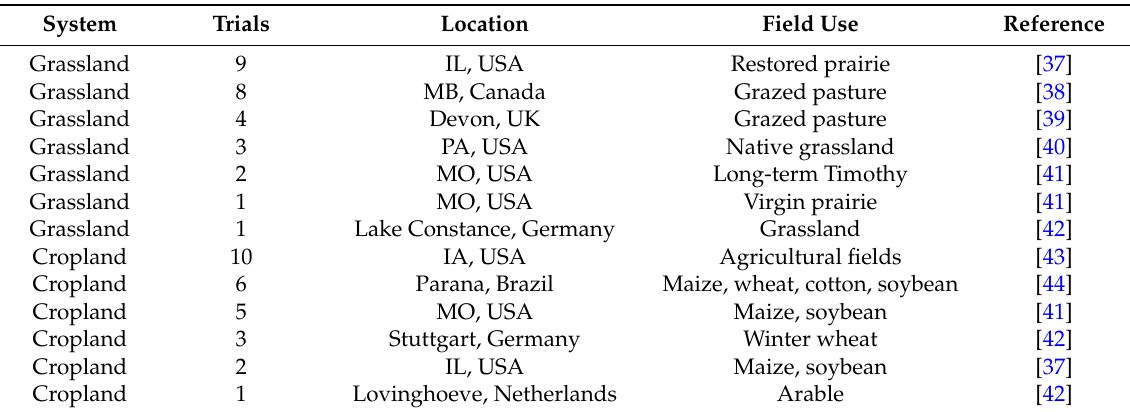
Table 1. Source data for the meta-analysis.